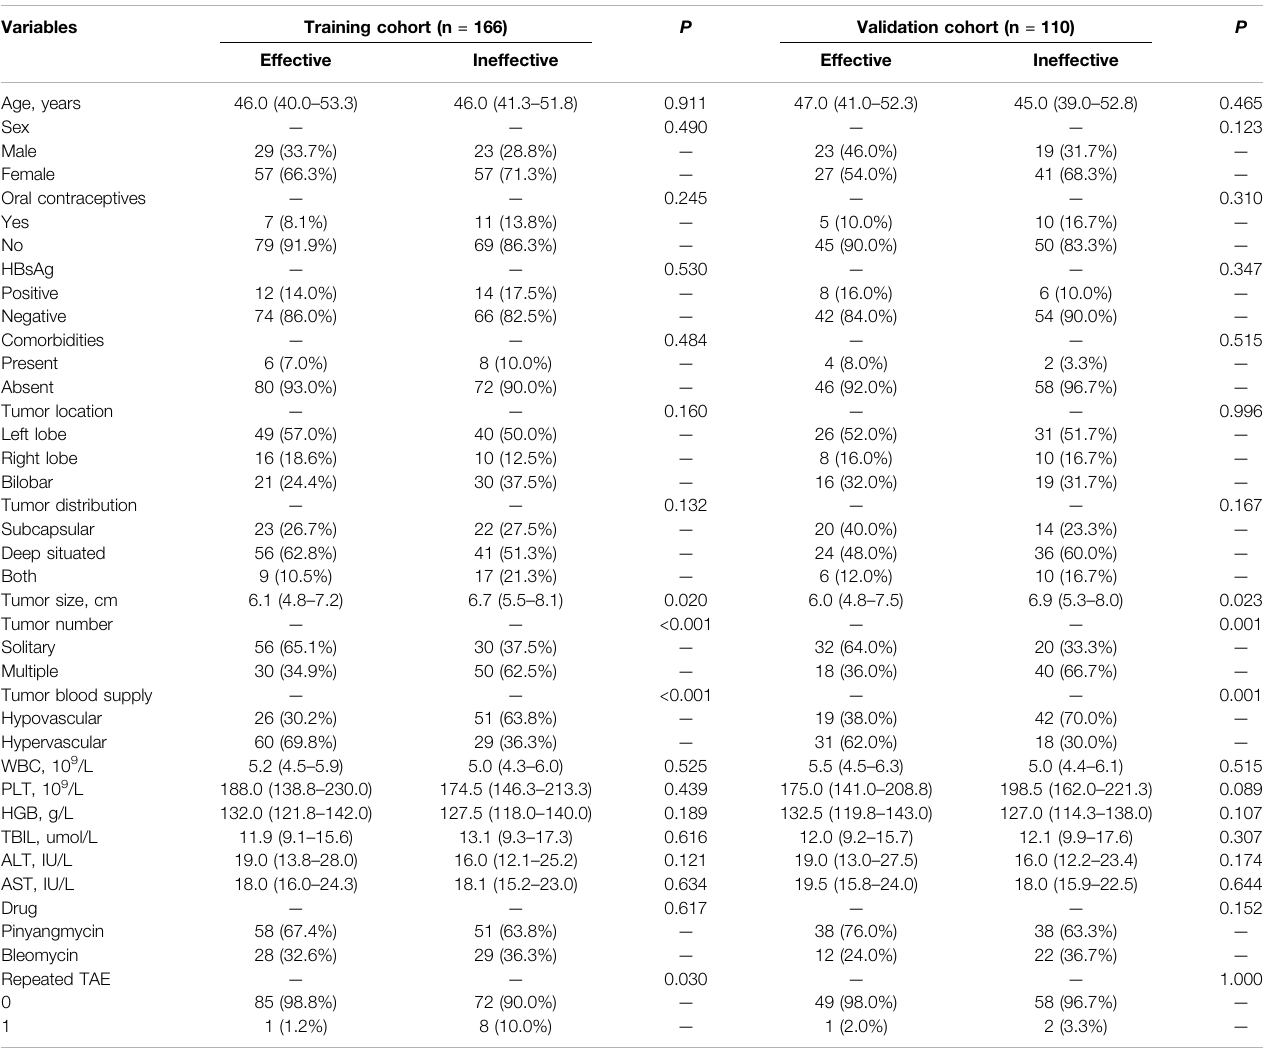
TABLE 1 | Demographic characteristics of patients with hepatic hemangioma in the training and validation cohorts.